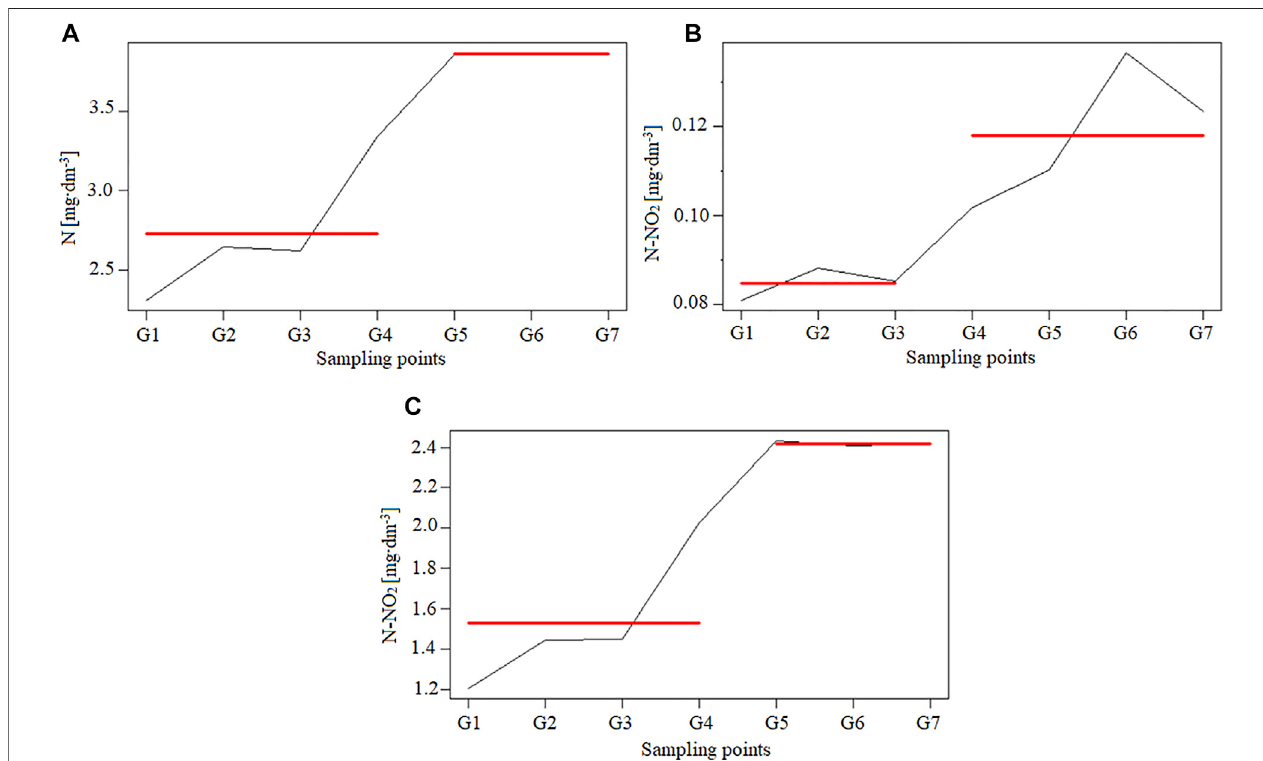
FIGURE4| Averagecontentsof (A) totalnitrogen; (B) nitritenitrogen; (C) nitratenitrogen; inthewaters oftheG ł uszynkariverinthehydrologicalyears2016 – 2018, with the in fl ection point indicated.